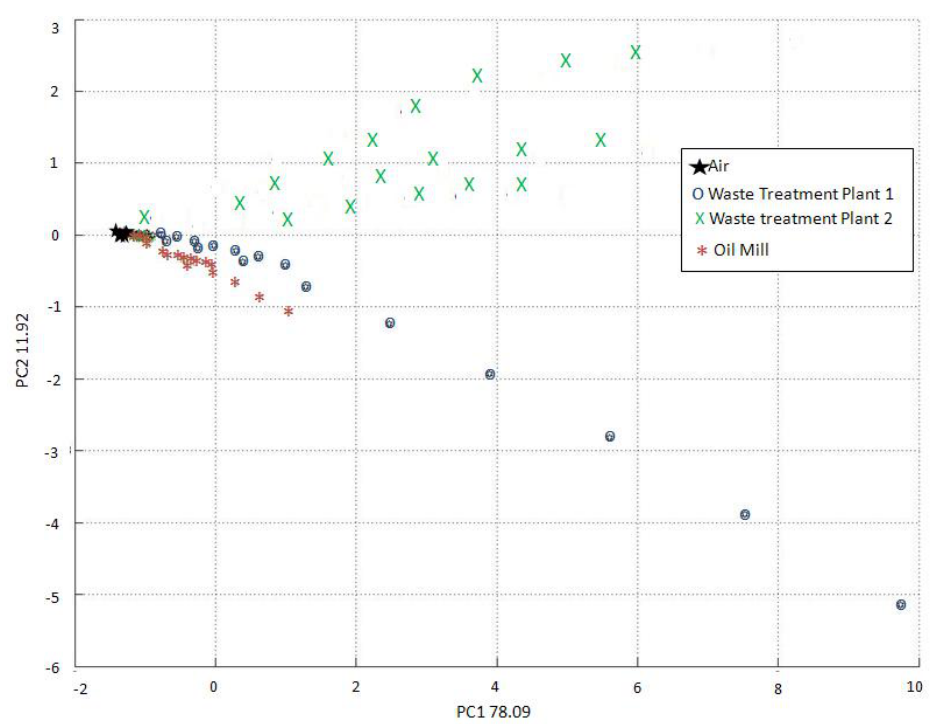
Figure 11. PCA of the EOS 507 training